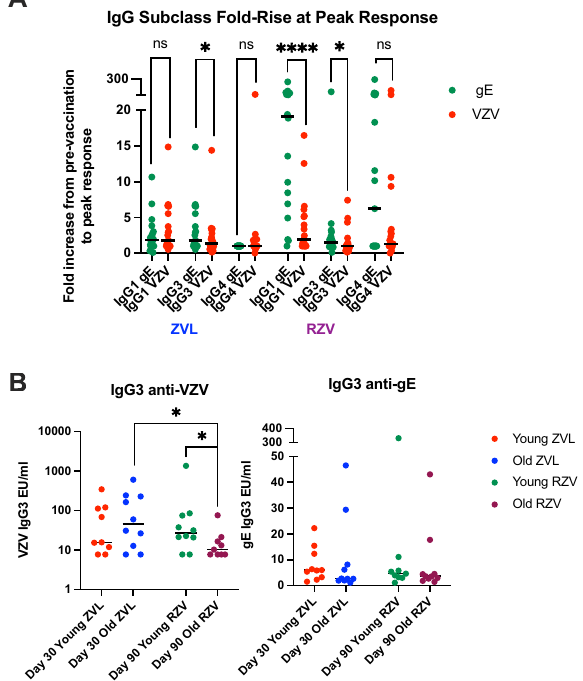
Fig. 3 IgG subclass antibody responses to ZVL and RZV. Data were derived from 20 ZVL and 19 RZV recipients. Each symbol represents a study participant. Lines represent medians. Panel A shows IgG fold- increases from pre-vaccination to peak response. Paired comparisons of IgG1, IgG3 and IgG4 anti-gE (green) and anti-VZV (red) responses measured by Wilcoxon signed rank test (nonparametric) are shown on the graph. Panel B shows IgG3 anti-VZV (left) and anti-gE (right) peak responses. Signi fi cant differences between age and vaccine groups performed by Mann-Whitney test (nonparametric) are shown on the graph. * indicates 0.01 < p < 0.05; **** indicates p <